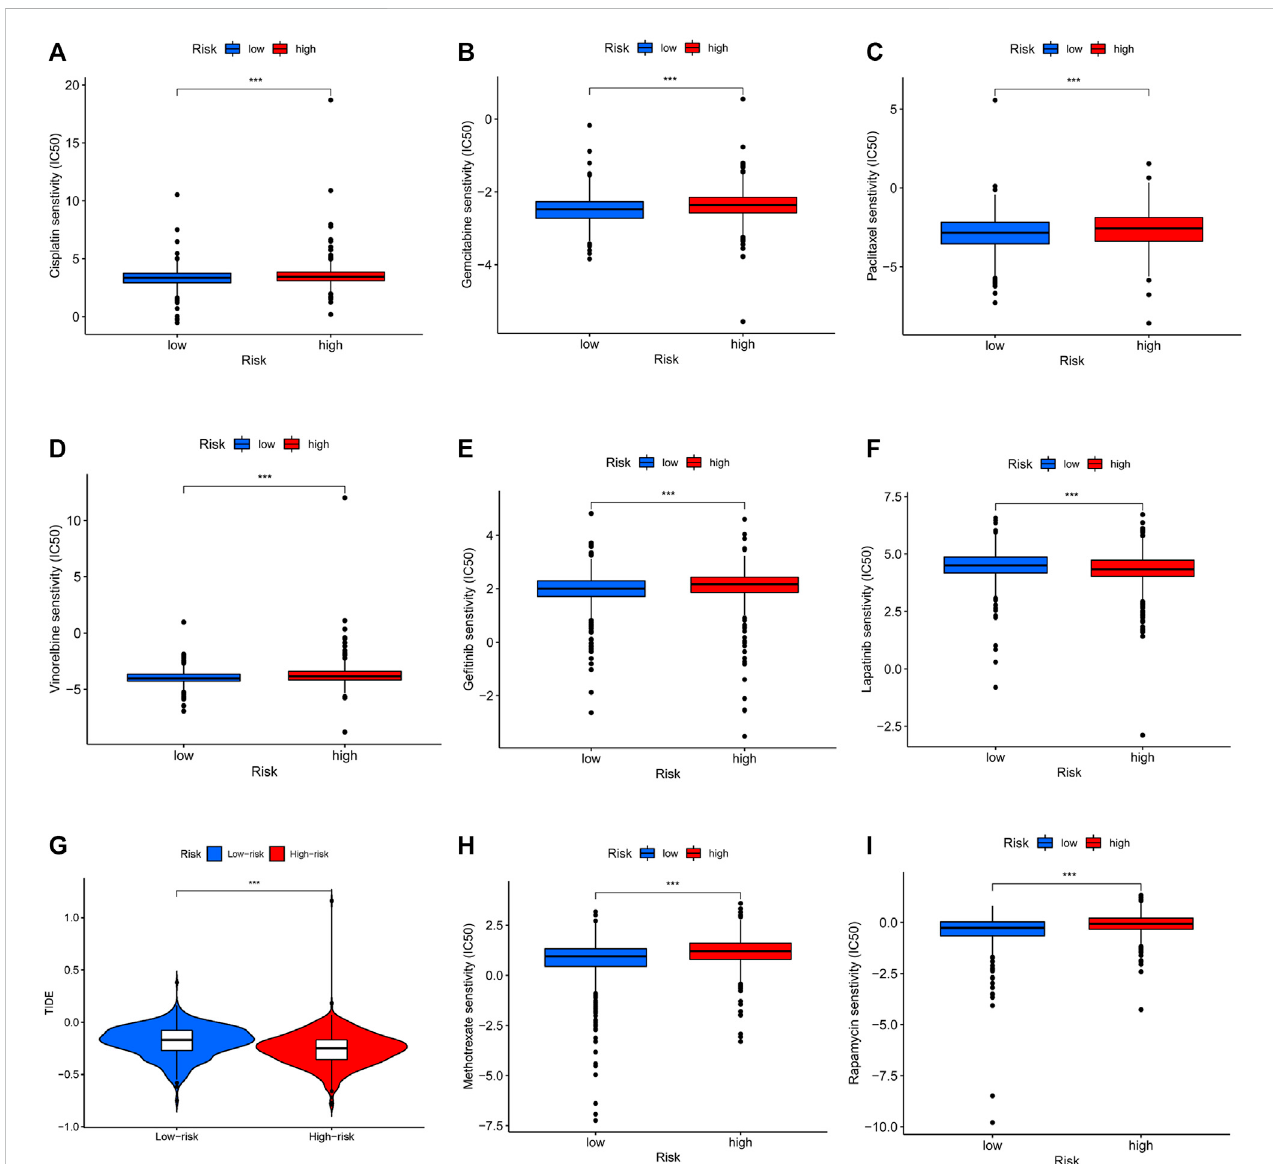
FIGURE 10 Differential sensitivity to chemotherapies and immunotherapy between the high- and low-risk patients with BC. BC, breast cancer. *** p < 0.001.